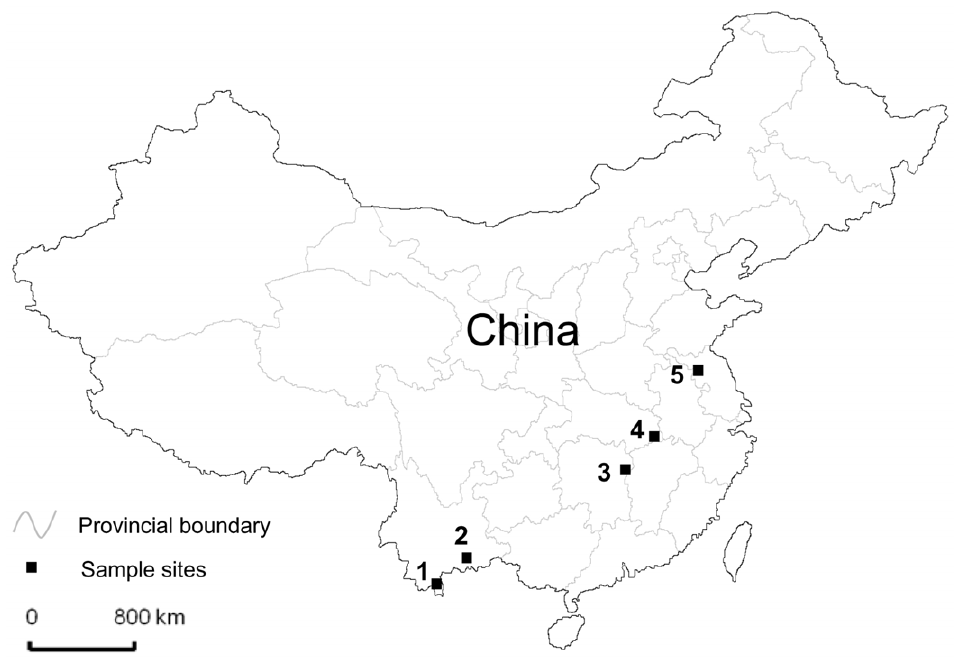
Figure 1. A map of China showing the distribution of mosquito sampling sites. Site name: 1, Mengla county (Yunnan Province); 2, Yuanyang county (Yunnan Province); 3, Liuyang county (Hunan Province); 4, Wuxue county (Hubei Province); and 5, Sihong city (Jiangsu Province).